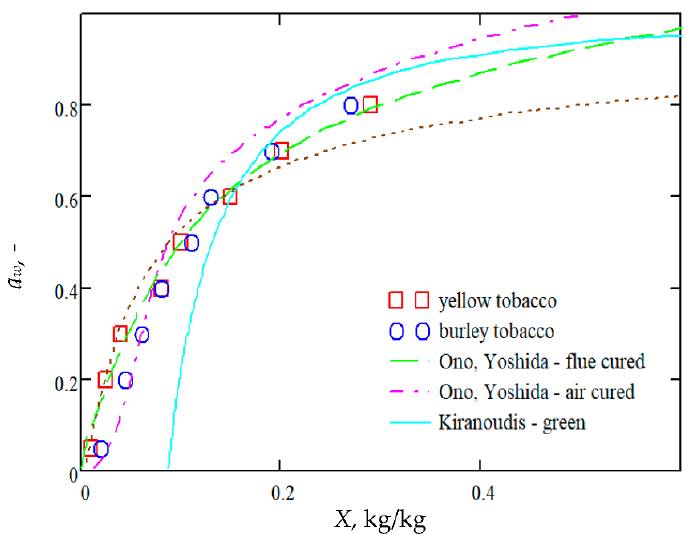
Figure 1. Comparison of experimental data obtained by References [11,12] and several empirical sorption isotherm equations for tobacco.